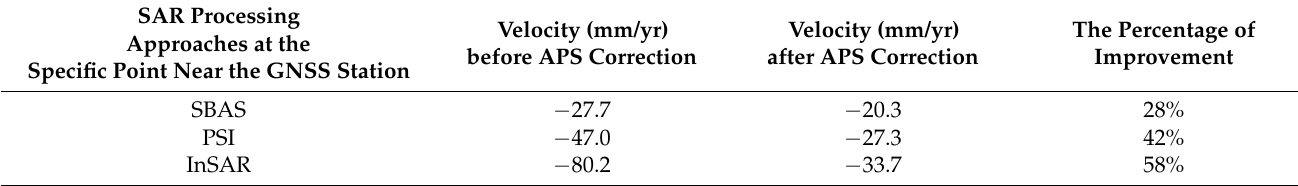
Figure 8. Comparison of obtained APS-corrected mean displacement rates with GNSS data. Table 2. The percentage of improvement in each SAR processing approach via APS